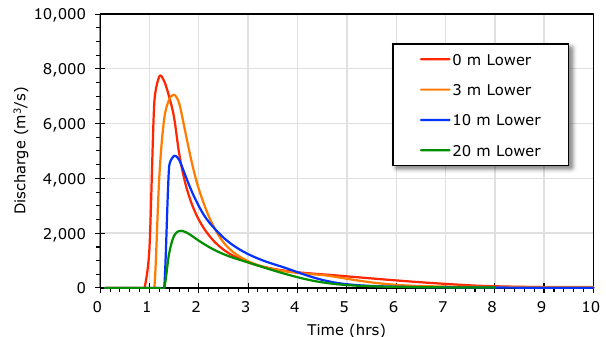
Figure 8. GLOF hydrographs at Dingboche under current lake conditions for 0 m, 3 m, 10 m and 20 m lake lowering scenarios.